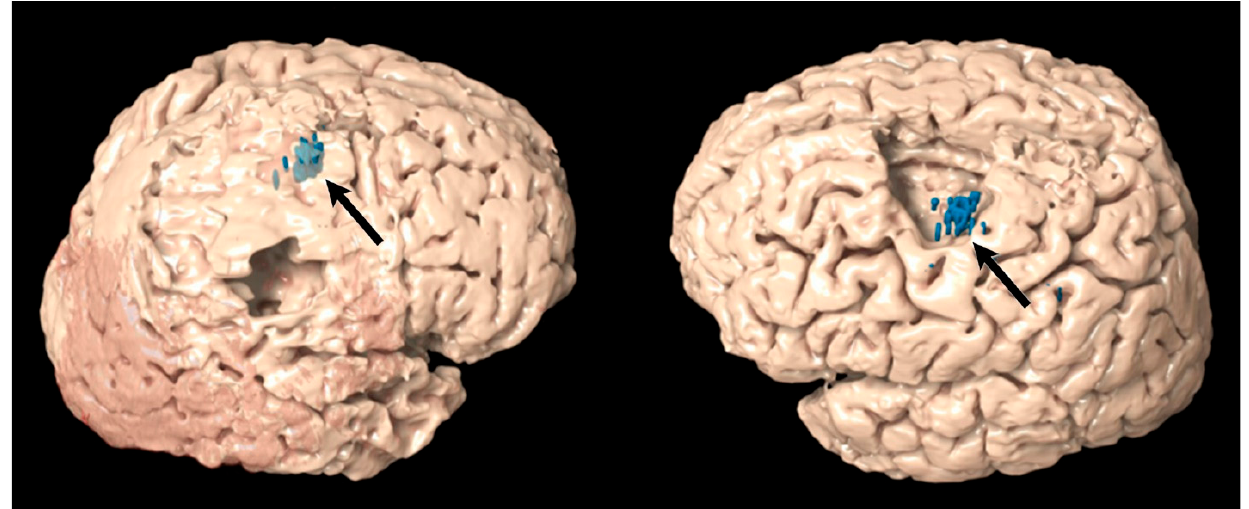
Figure 2. 3D reconstruction of TMS points overlayed onto the postoperative resection cavity. Image on left shows a patient with no TMS points resected, while the image on the right shows a patient with several TMS points resected. Arrow points to the TMS points (blue).